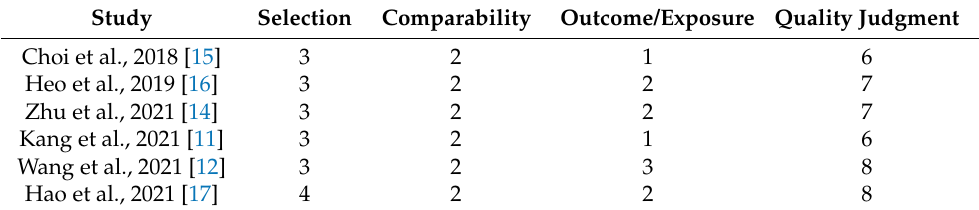
Figure 2. Risk of bias summary: review authors’ judgement regarding each risk-of-bias item for RCT. Green round represents low risk and yellow round represents not mentioned in the article Hu et al., 2021 [13]. Table 2. Quality Assessment of Included Studies Based on Newcastle–Ottawa Scale.